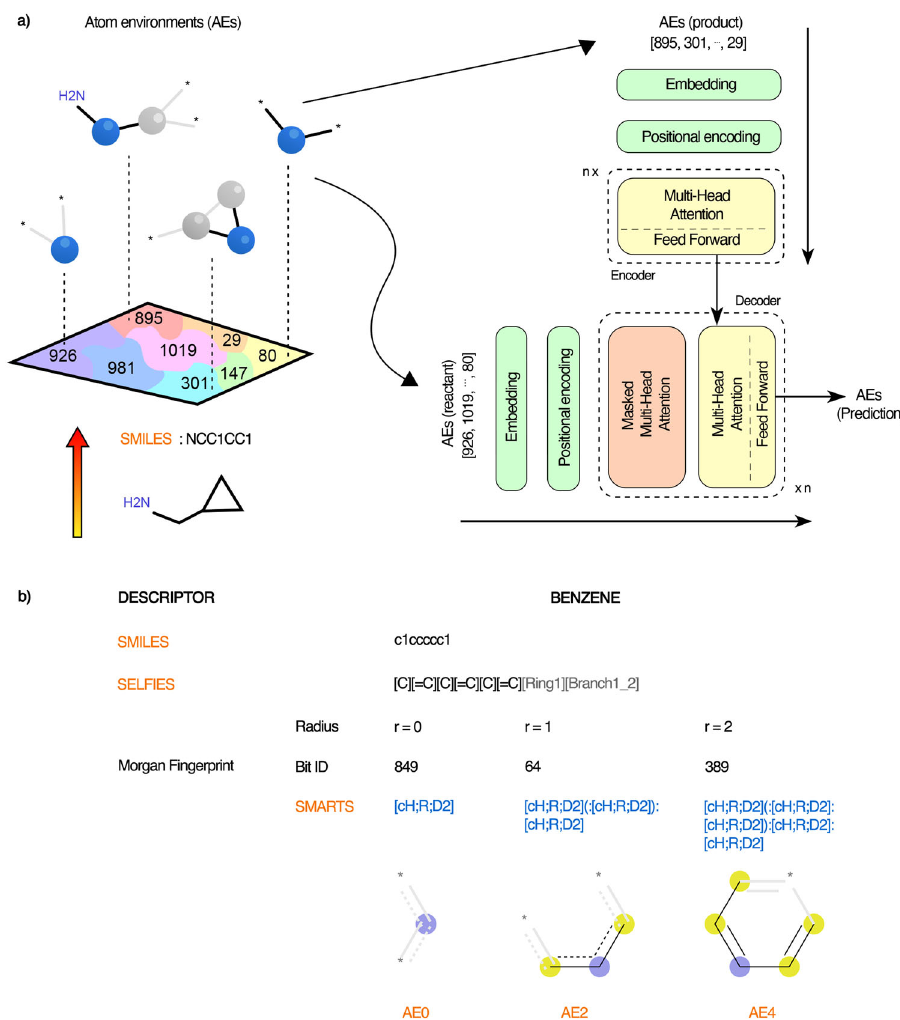
Fig. 1 The model framework. a A schematic of RetroTRAE including the input – output structure. b String representations of benzene are presented in the form of SMILES, SELFIES, and as a combination of SMARTS patterns generated by the Morgan fi ngerprint. In AEs renderings, the central atom is highlighted in blue whereas aromatic and aliphatic ring atoms are highlighted in yellow and gray, respectively. A wildcard [*] is used to represent any similar with respect to the level of information they display. The text sections of the SMARTS description contain two levels of detail: the fi rst level represents the aromaticity and H count of the element, and the second level includes the number of neighboring heavy atoms and ring information (represented by “ D ” and “ R ” , respectively). By de fi nition, AEs with radius r = 0 only include the atoms of the central atom type. We denote the set of all AEs with r = 0 as AE0. AEs with r = 1 contain the central atom, all atoms adjacent to the central atom (nearest neighbors), and all the bonds between these atoms. The set of all AEs with r = 1 is denoted as AE2.